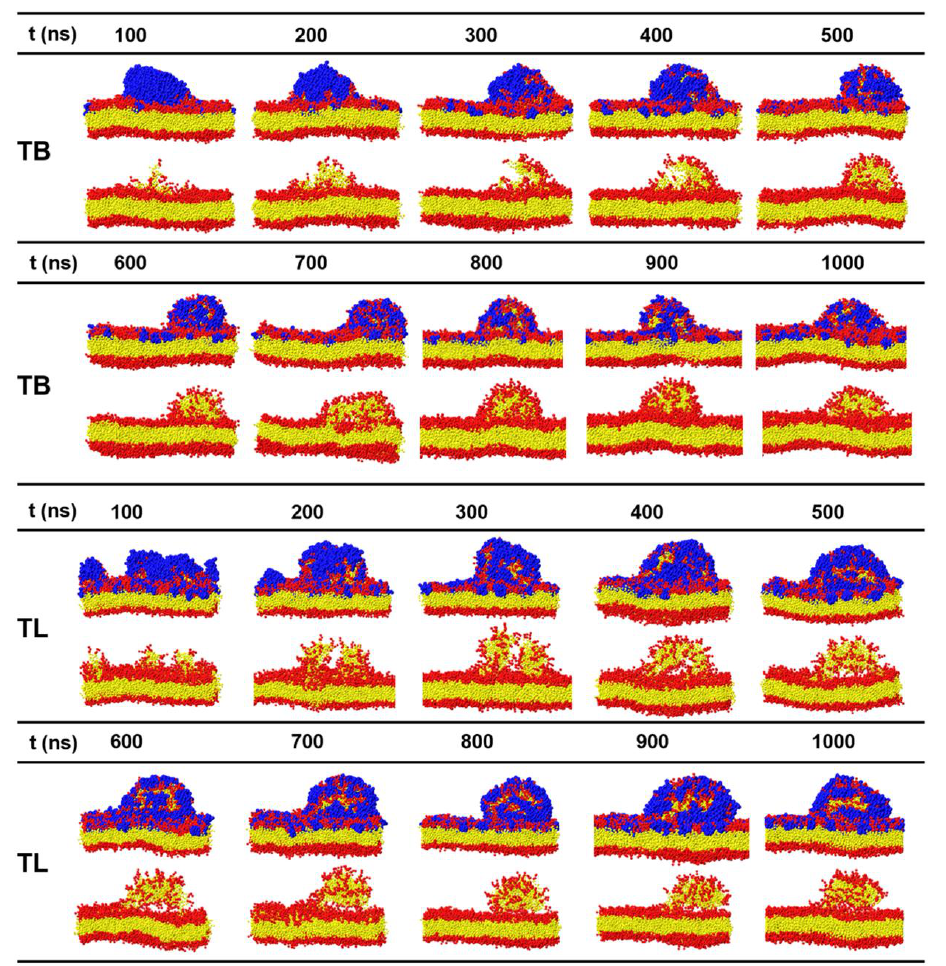
Figure 7. Time sequences of snapshots of lipid bilayer treated with TBs and TLs at a concentration of P/L = 10%. In a few simulated samples, the peptides were observed forming multiple small ag- gregates (for example TB at P/L = 7.3%). The clustered peptides coordinate and insert into the hydrophobic core region of the membrane forming barrel-like transmembrane chan- nels. Hydrophilic residues crowd in the inner wall of the channel (invisible in Figure 8) and permit water to pass. The pores are metastable, and the peptides finally translocate to the opposite leaflet of the bilayer. We did not observe TL-induced pore formation. We note that in order to accelerate the peptide binding but avoid improper binding onto the distal leaflet of a membrane in a periodic box, peptides were placed very close to the upper membrane surface (less than 2 nm) in our simulations. As a result, at high pep- tide concentrations, AMPs aggregate quickly before they approach to the membrane sur- face due to hydrophobic attractions (see the early binding process at P/L = 10% in Figure S4). If the peptide were placed more dispersed in the initial condition, multiple small ag- gregates may form. They may further fuse and bind to the membrane surface in a slow fashion. Nevertheless, we speculate that the results obtained so far will not change.